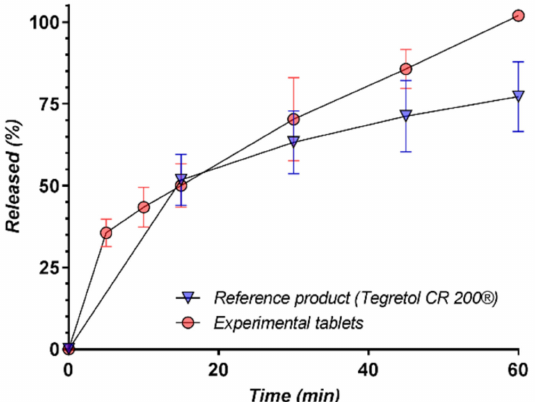
Figure 10. Comparison of the in vitro release profiles of CBZ from the experimental chewable tablets containing the CBZ- β -CD complex and from the commercial reference carbamazepine tablet product in LSS